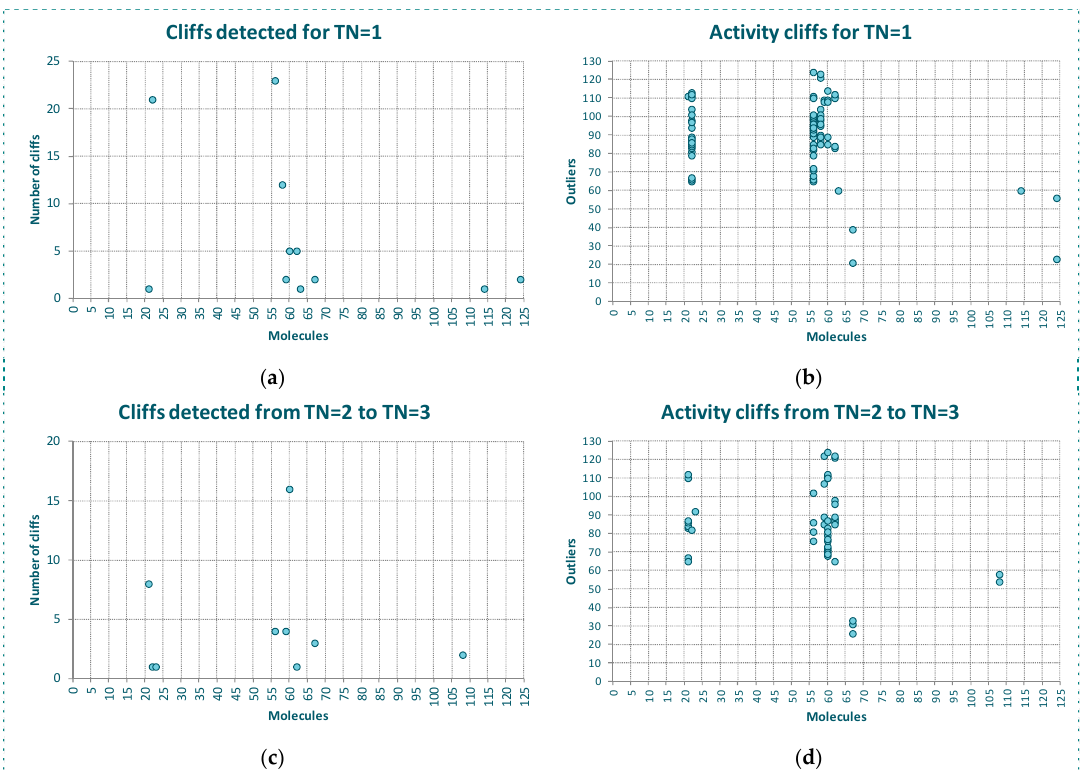
Figure 3. Study of the outlier behavior for YES1 dataset: ( a , c ) number nearest neighbors of a different class for the molecules of the dataset, ( b , d ) pairs of activity cliffs molecules.